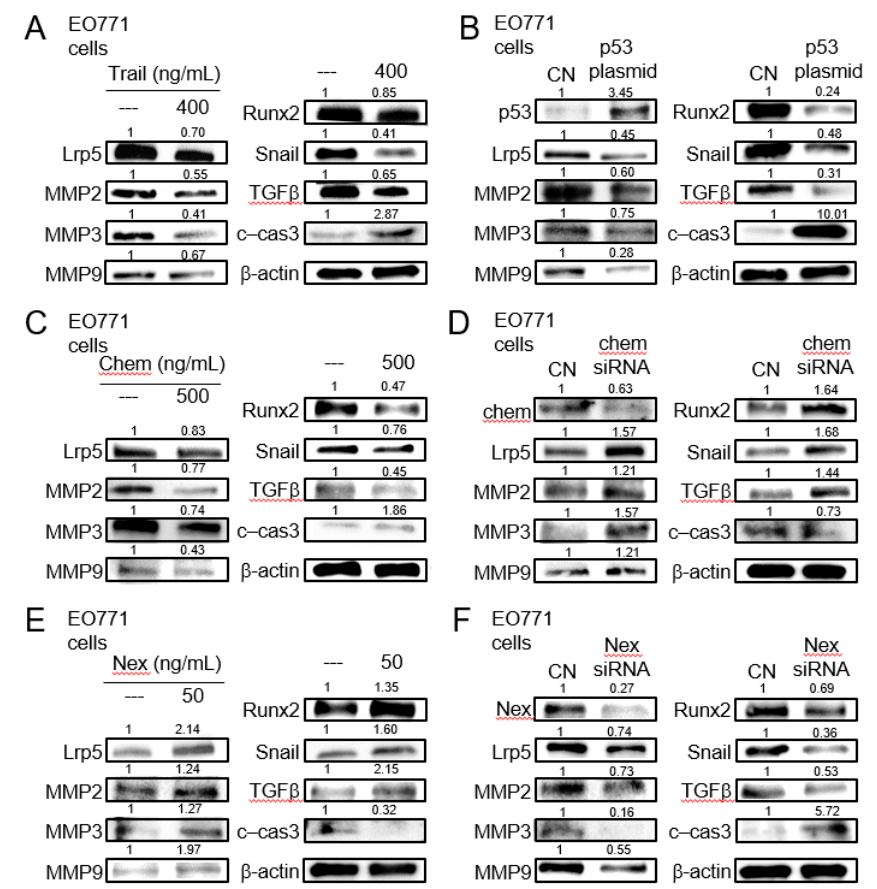
Figure 5. Expression of Lrp5, MMP2, MMP3, MMP9, Runx2, Snail, TGF β , and cleaved caspase 3 in EO771 mammary tumor cells. CN = control, c-cas 3 = cleaved caspase 3, Chem = chemerin, and Nex = nexin. ( A ) Response to the administration of TNF-related apoptosis-inducing ligand (TRAIL). ( B )Response to the transfection of p53. ( C ) Response to the administration of chemerin. ( D ) Response to RNA interference with chemerin siRNA. ( E ) Response to the administration of nexin. ( F ) Response to RNA interference with nexin